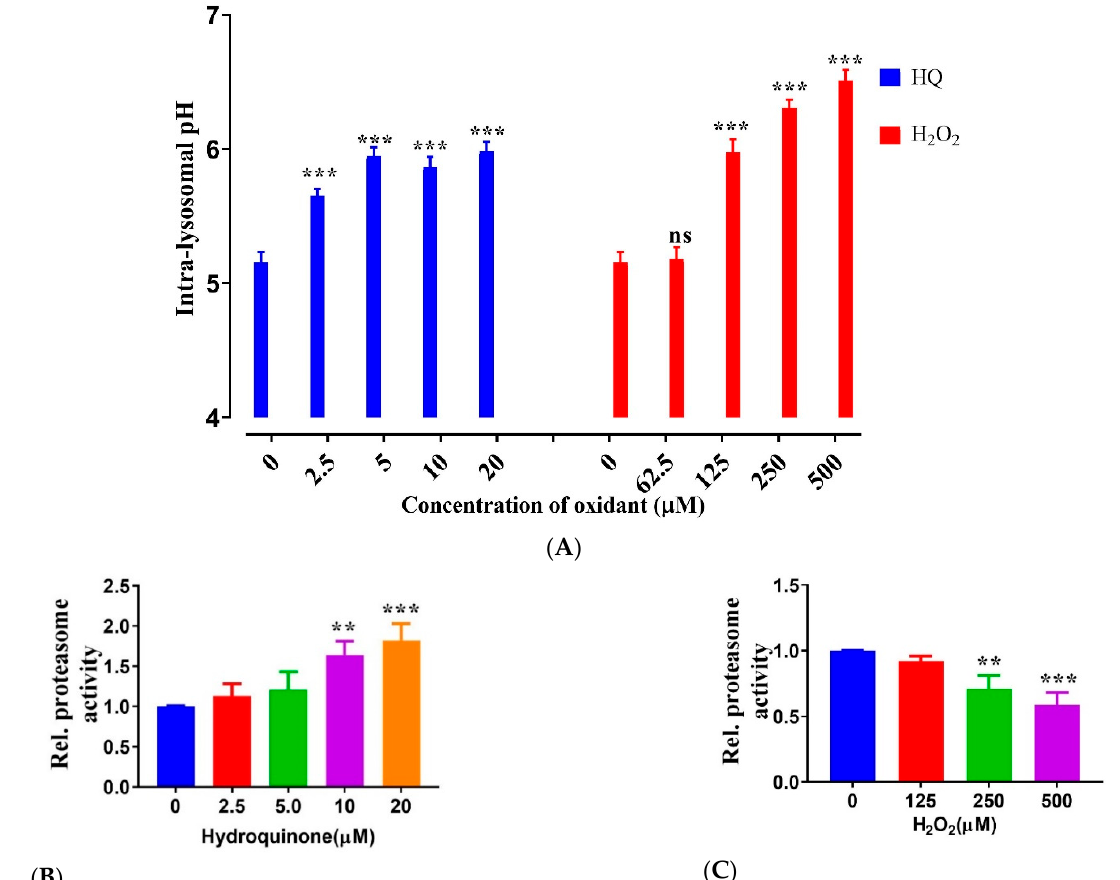
Figure 5. Effect of oxidants on lysosomal pH and proteasome activity. ( A ) Measurement of intra-lysosomal pH using LysoSensor™ Yellow/Blue DND-160 in ARPE-19 cells plated in 96-well plates and incubated with HQ or H 2 O 2 for 2 h. ( B , C ) Proteasome activity using a fluorogenic substrate for detection of chymotrypsin-like activity in cells treated with HQ or H 2 O 2 for 2 h. Data represent the mean + SD of 3 independent experiments of 3 replicates each. Statistical analysis using one-way ANOVA followed by Dunnett’s multiple comparison test. ** p < 0.01, *** p < 0.001, significant difference relative to the controls.